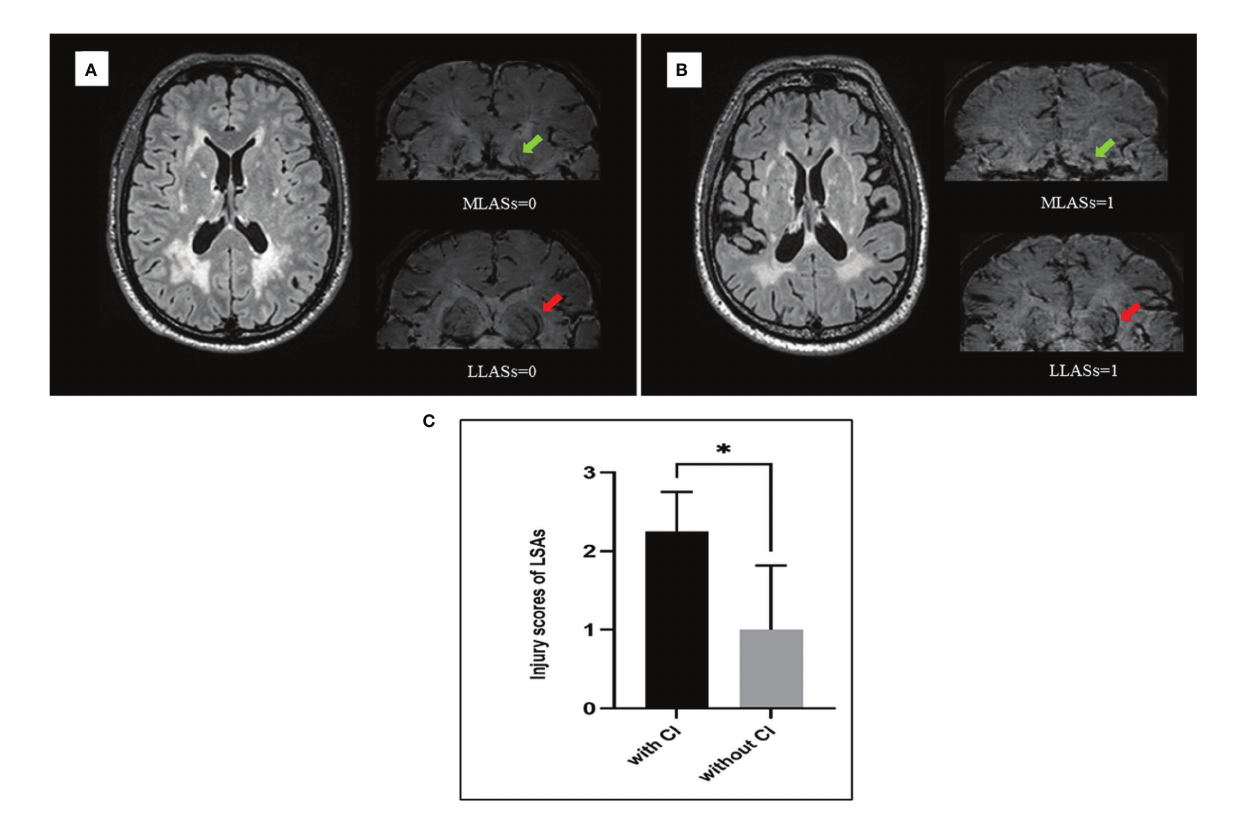
FIGURE 3 | The injury severity of lenticulostriate arteries (LSAs) was different between patients with and without cognitive impairment when under similar white matter hyperintensities (WMH). (A) male, 50 years old, had severe WMH and normal cognitive function, the injury scores of medial and lateral LSAs were 0 separately. (B) male, 52 years old, had severe WMH and cognitive impairment, the injury scores of medial and lateral LSAs were 1 separately. (C) Eight patients with severe WMH were divided into two groups matching for sex, age, and risk factors. One group consists of four patients who had cognitive impairment and another group consists of four patients who had normal cognitive function. The injury scores of LSAs were statistically different between two groups (p=0.04). MLASs, medial lenticulostriate arteries; LLSAs, lateral lenticulostriate arteries; CI, cognitive impairment. *p <